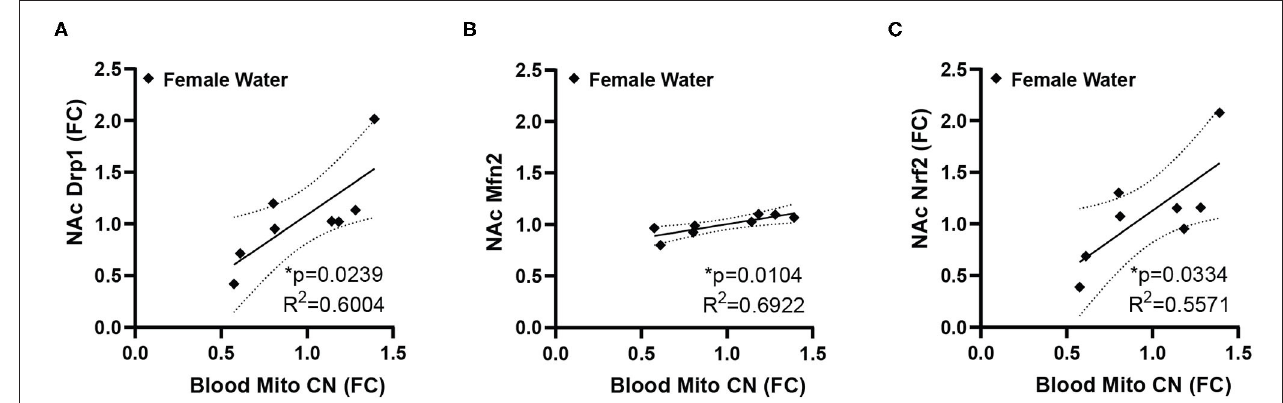
FIGURE 2 | Blood mitochondrial copy number correlates with NAc gene expression in female mice. In female control mice blood mitochondrial copy number correlates with (A) NAc expression of Drp1 (B) Mfn2, and (C) Nrf2. Blood copy number and NAc gene expression are depicted as fold change. * p <